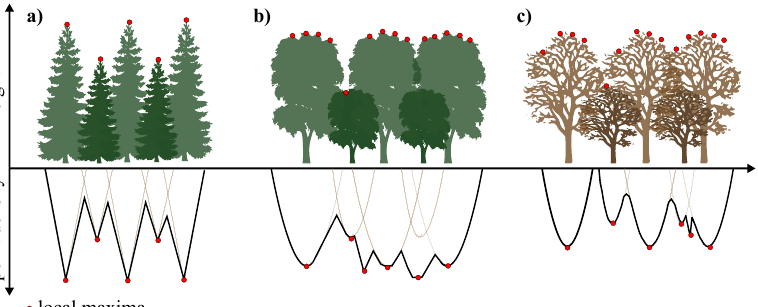
Figure 4. Comparison between the performance of the local maxima (upper row) and the density- based (lower row) approaches when applied to ( a ) coniferous stands, and to deciduous tree stands in ( b ) leaf-on and ( c ) leaf-off